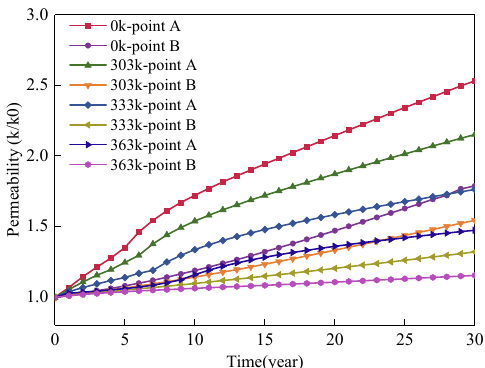
ff erent injection